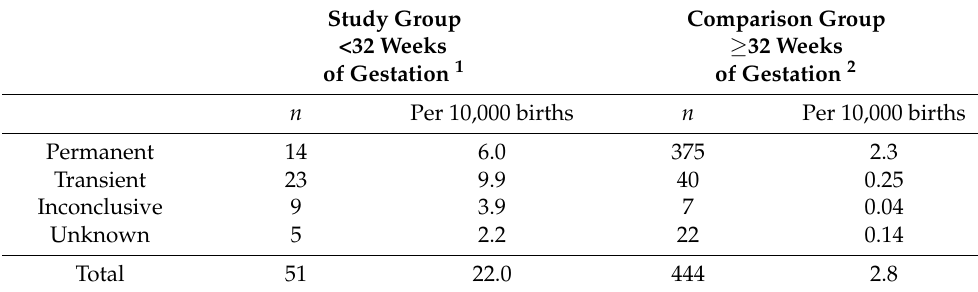
Table 3. Comparison of prevalences <32 and ≥ 32 weeks of gestation.